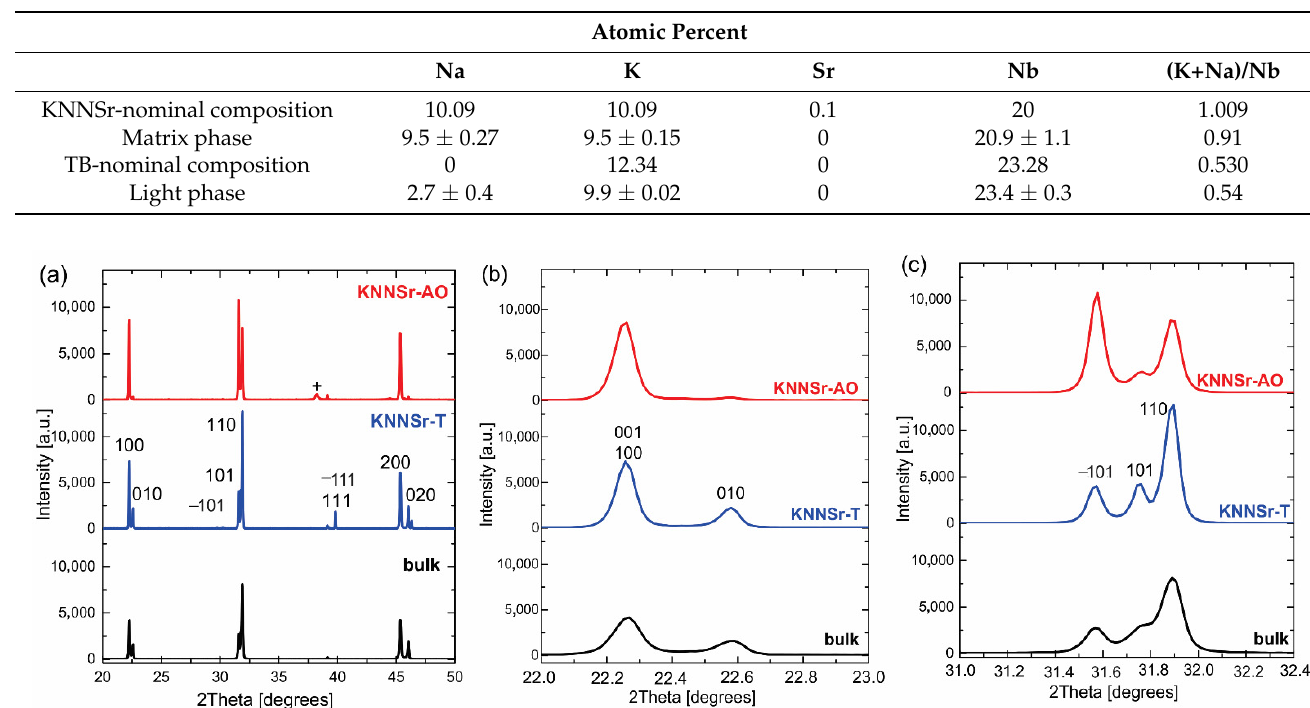
Table 1. EDXS analysis of KNNSr thick films.